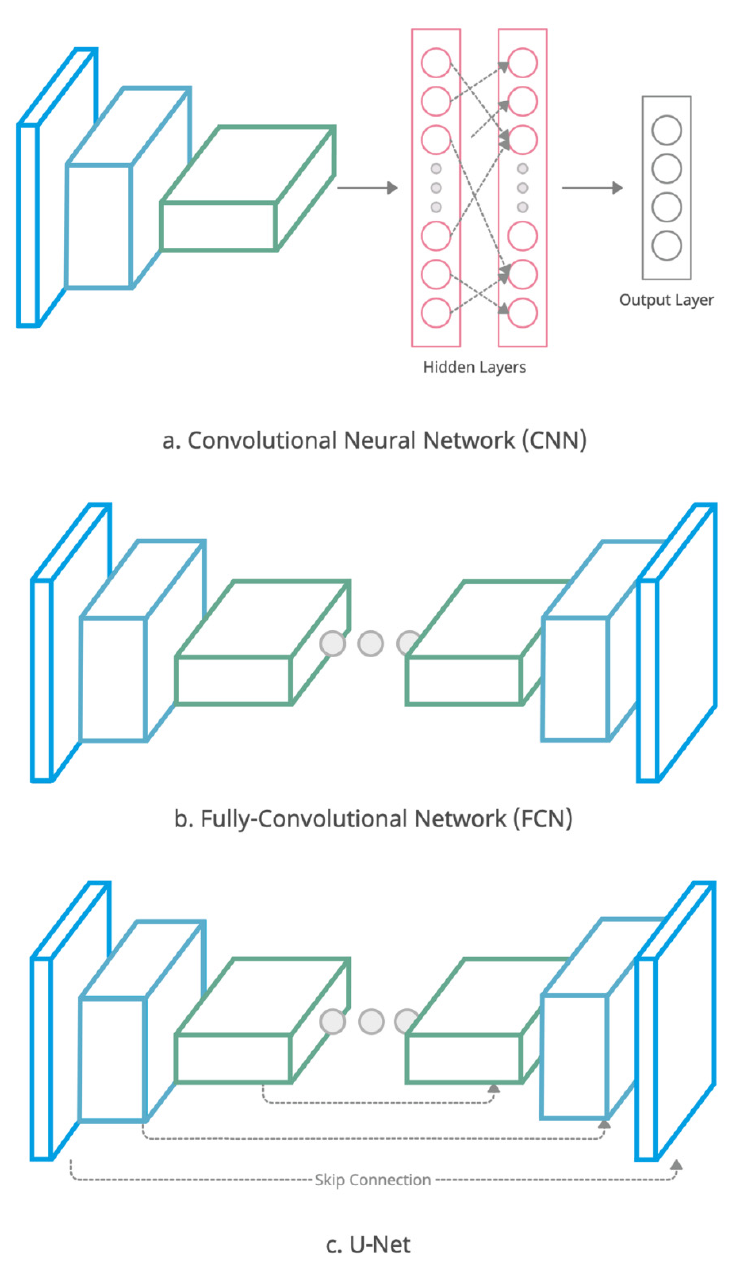
Figure 2. Illustration of ( a ) convolutional neural networks (CNN) with fully-connected final layers for classification tasks, ( b ) fully-convolutional network (FCN) for image-to-image or image-to-mask translations and ( c ) U-Net architecture with skip connections between encoder and decoder in the network for more efficient feature extraction/reconstruction than FCN.